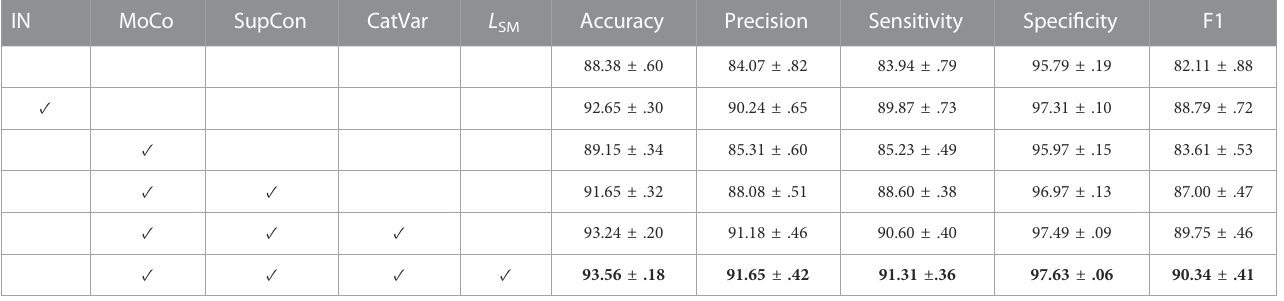
TABLE 2 Ablation study of the SupCAM model with ResNet50 on the 30% test set of the ChrCluster dataset. We repeated all experiments 10times and report the mean and standard deviation. IN indicates that the backbone network has been pre-trained by the ImageNet dataset. CatVar, category-variant image composition method; L SM , self -margin